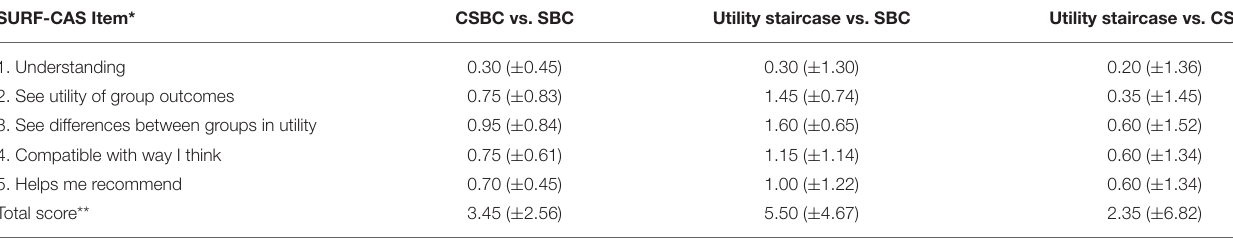
SURF-CAS Item* CSBC vs. SBC Utility staircase vs. SBC Utility staircase vs. CSBC